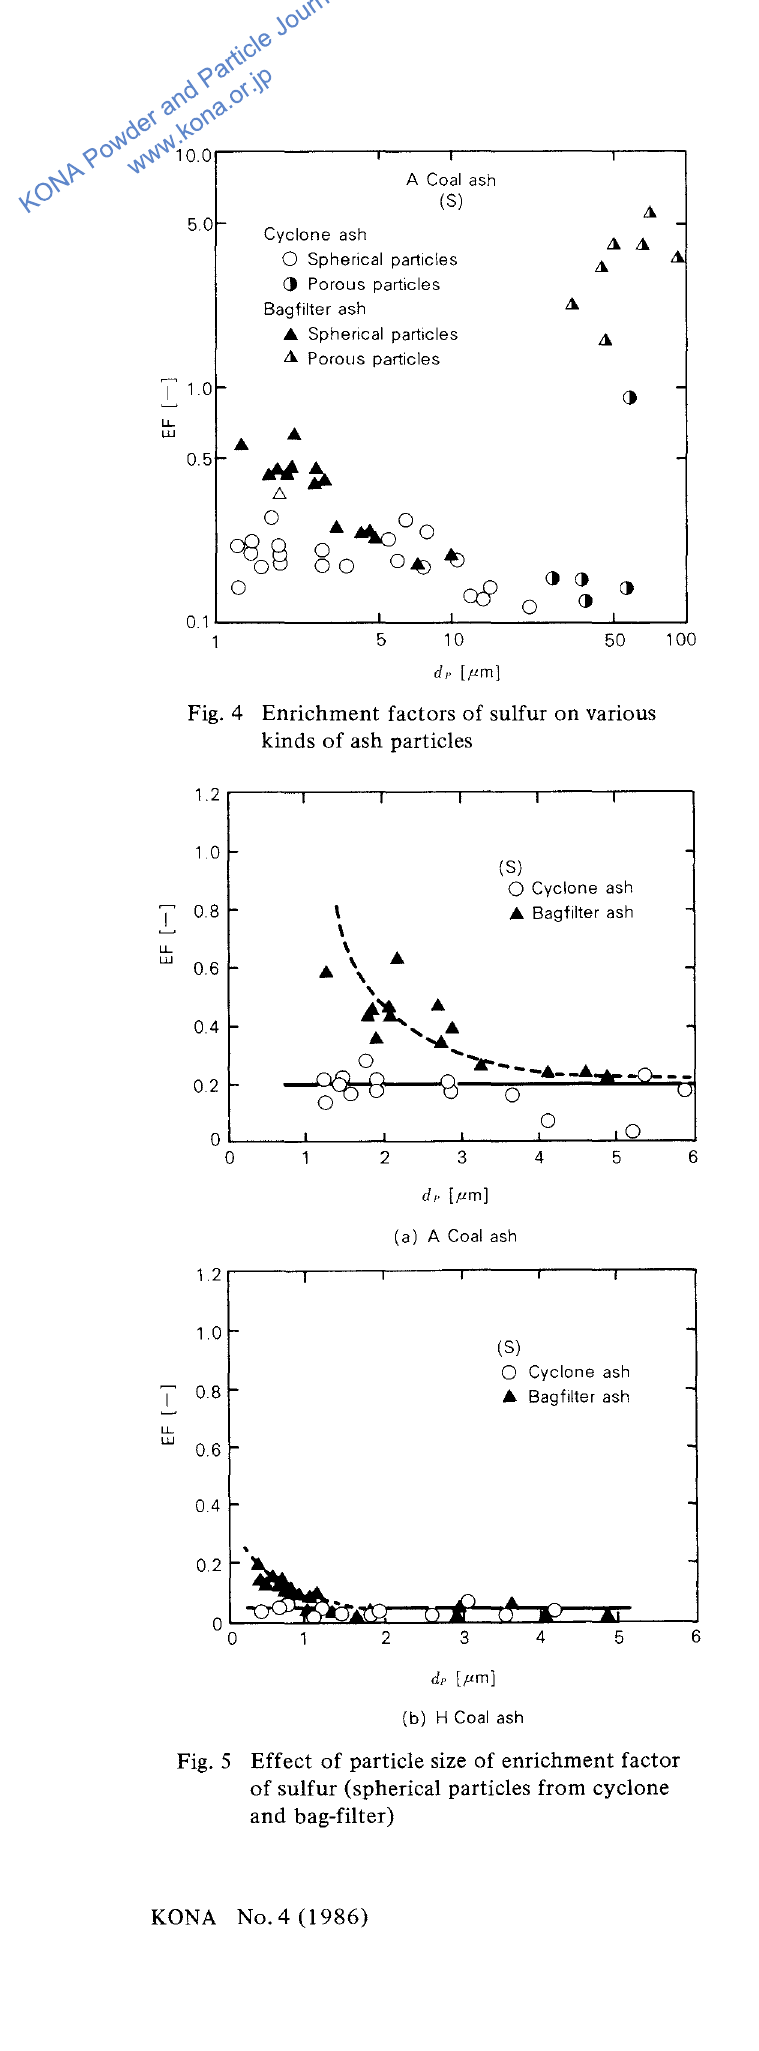
Fig. 5 Effect of particle size of enrichment factor of sulfur (spherical particles from